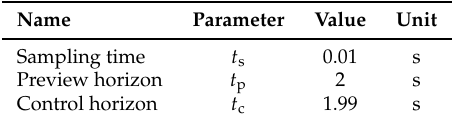
Table 4. Simulation settings.